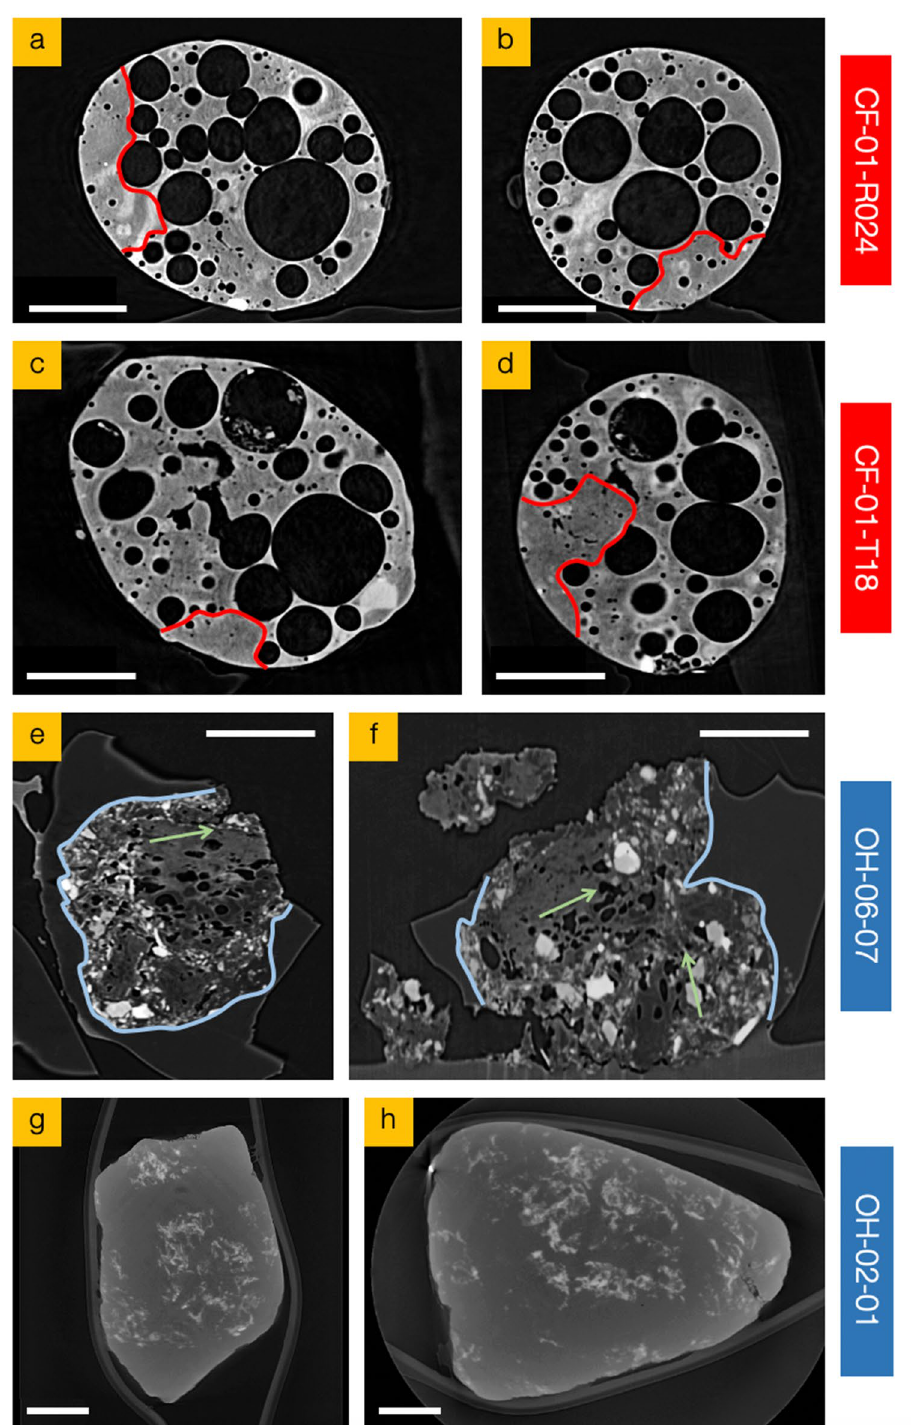
Figure 4. Laboratory X-ray tomography sections obtained at perpendicular orientations through the both central horizontal and vertical planes of two of the representative particulates from each suite; ( a , b ) CF-01-R024 (Unit 1), ( c , d ) CF-01-T18 (Unit 1) and ( e , h ) OH-06-07 (Unit 3), ( g , h ) OH-02-01 (Unit 3). Regions absent of voids within the representative Unit 1 particulates are red in ( a )–( d ). Scale bars = 100